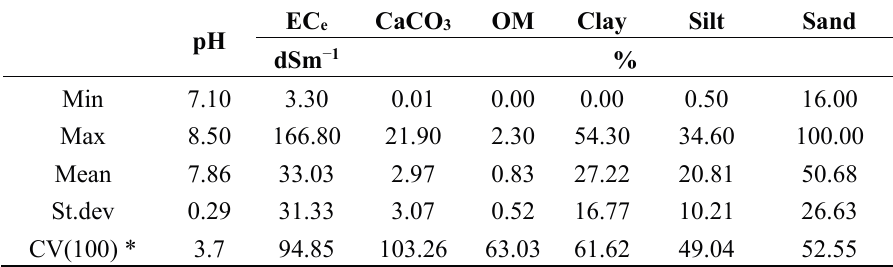
Table 1. Descriptive statistics of the soil